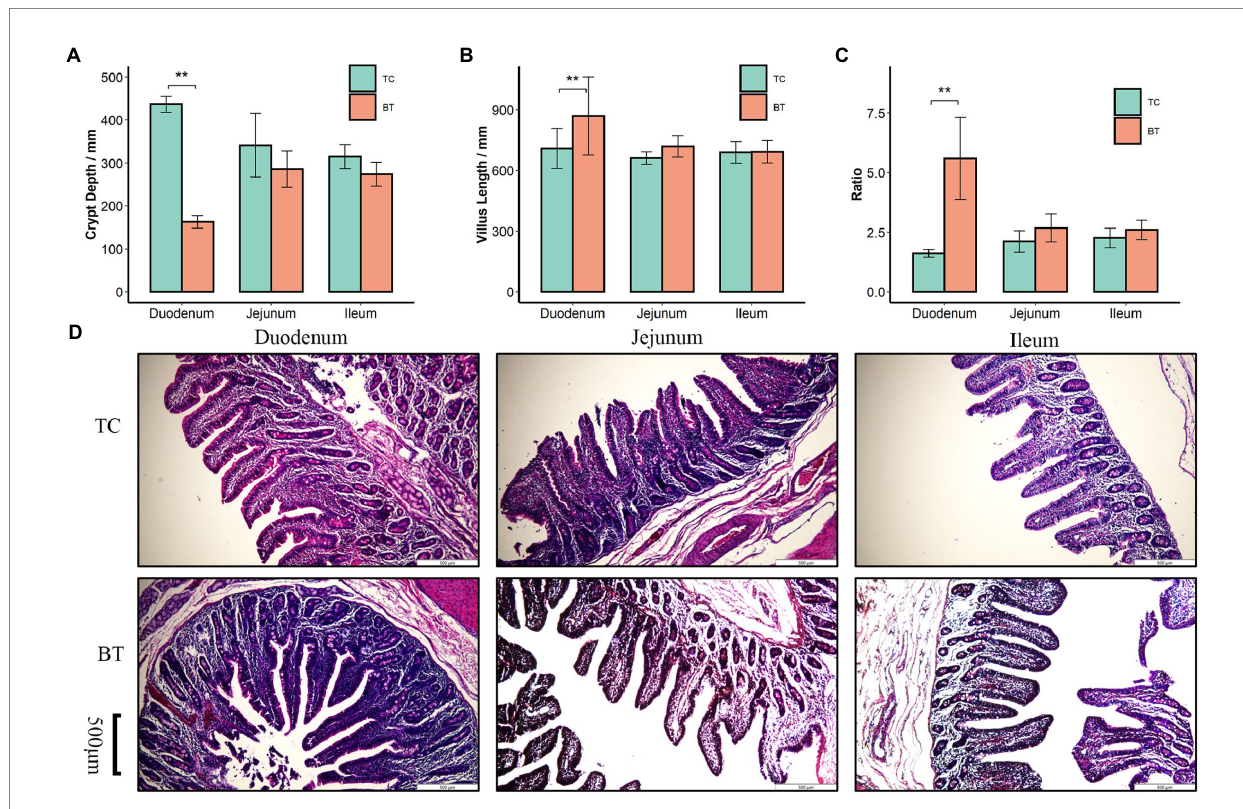
FIGURE 2 Histological analysis of the duodenum, jejunum, and ileum in TC pigs and BT pigs, the values showed in the bar presented as means ± SEM, and differences in the figures were marked by “*” and “**” while p < 0.05 and p < 0.01, respectively. (A) Crypt depth. (B) Villus length. (C) The ratio of villus length to crypt depth. (D) HE staining for histological